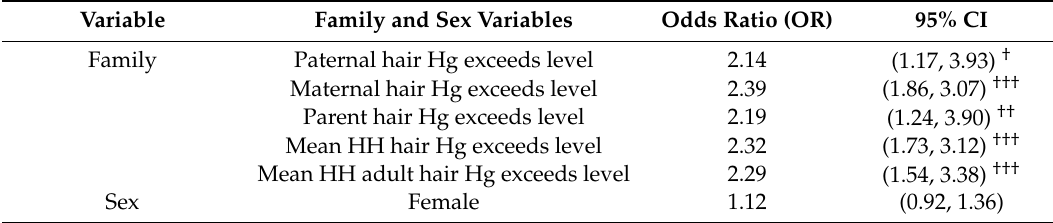
Table 3. Odds ratio (OR) for a child (<10 years) exceeding the 1.2 µ g/g level based on family and sex